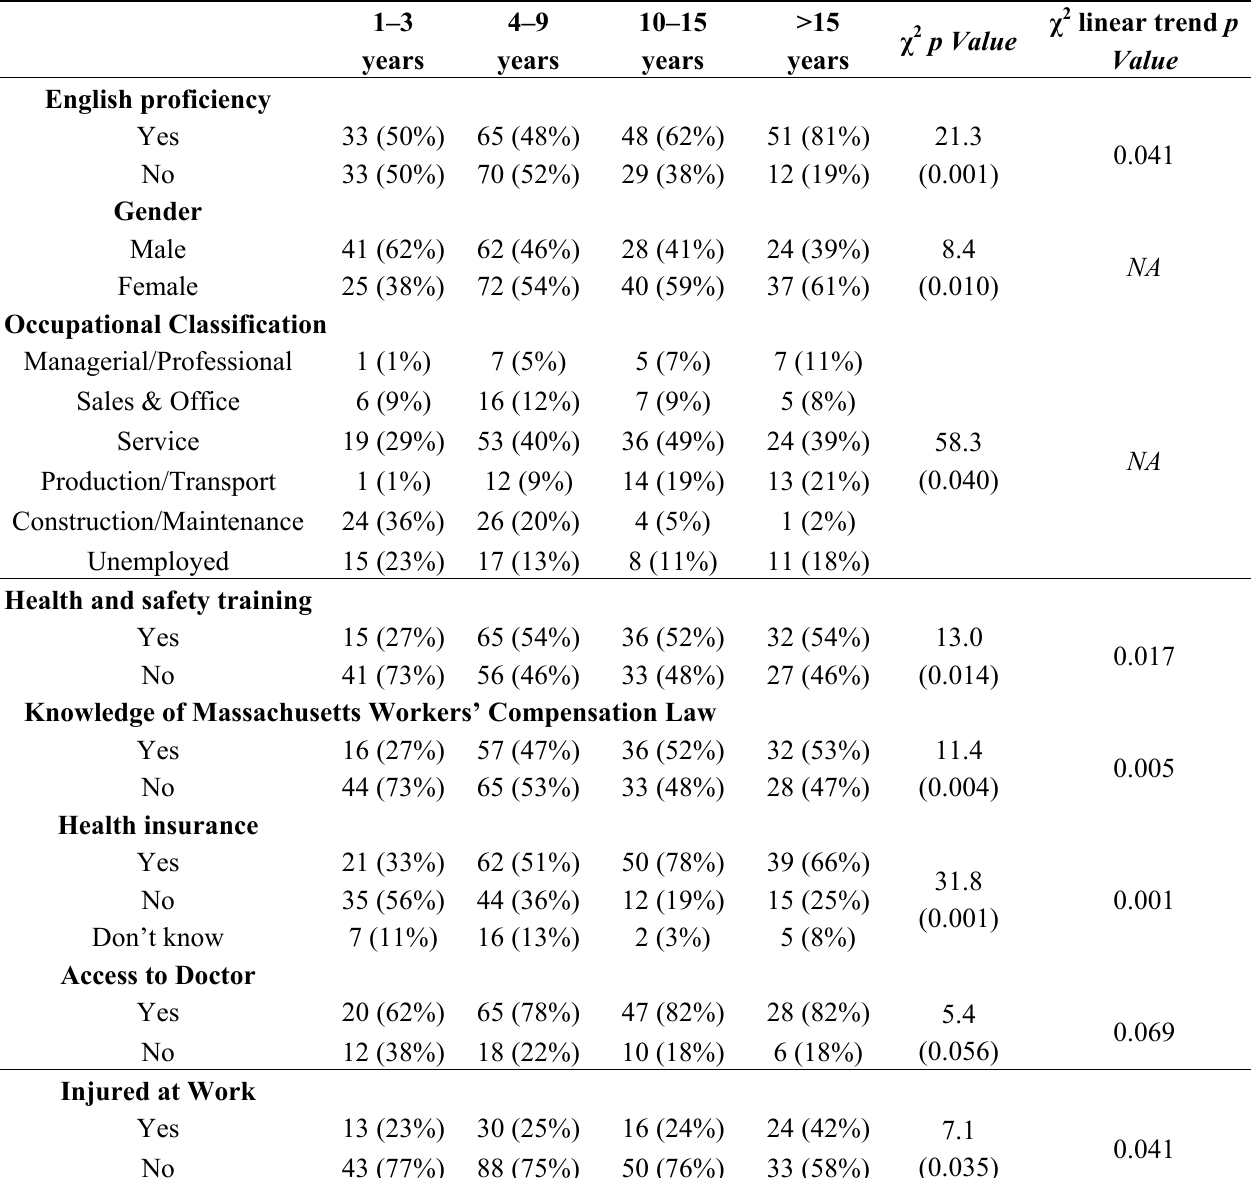
Table 2. Years in the US and demographic, occupation and health outcomes obtained from self-identified immigrant workers, Somerville, Massachusetts